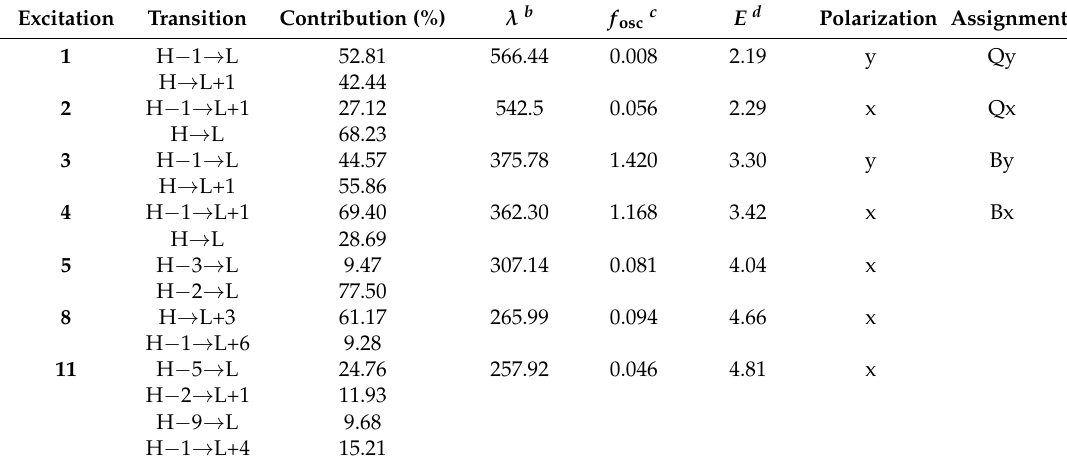
Table 5. Properties of the main electronic transitions of neutral unsubstituted (22)smaragdyrin ( 22S ) a .